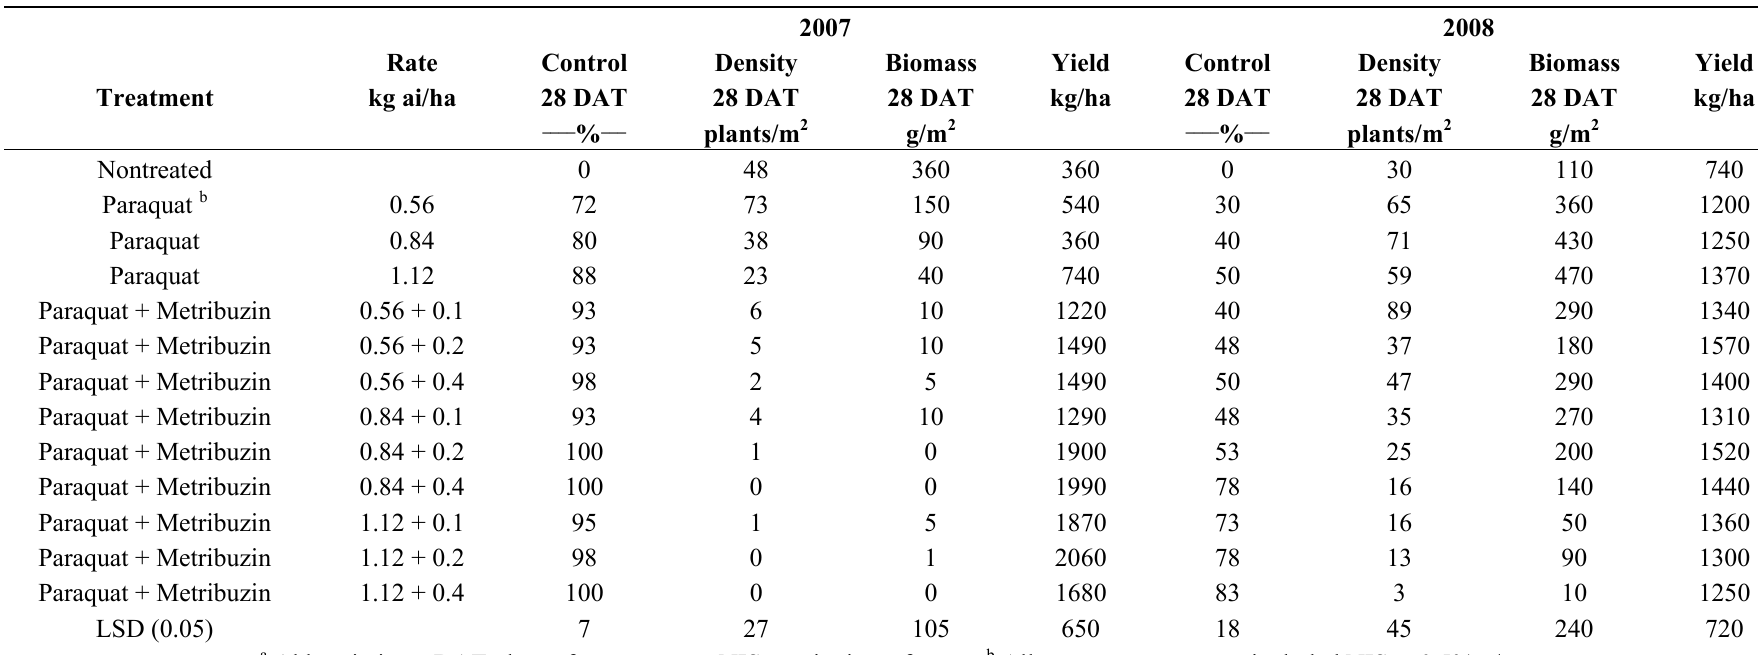
Table 1. Horseweed (10-cm) control, plant density, and biomass 28 day after treatment, and soybean yield near Stoneville, Mississippi a . 2007 2008 Rate Control Density Biomass Yield Control Density Biomass Yield Treatment kg ai/ha 28 DAT 28 DAT 28 DAT kg/ha plants/m 2 g/m 2 plants/m 2